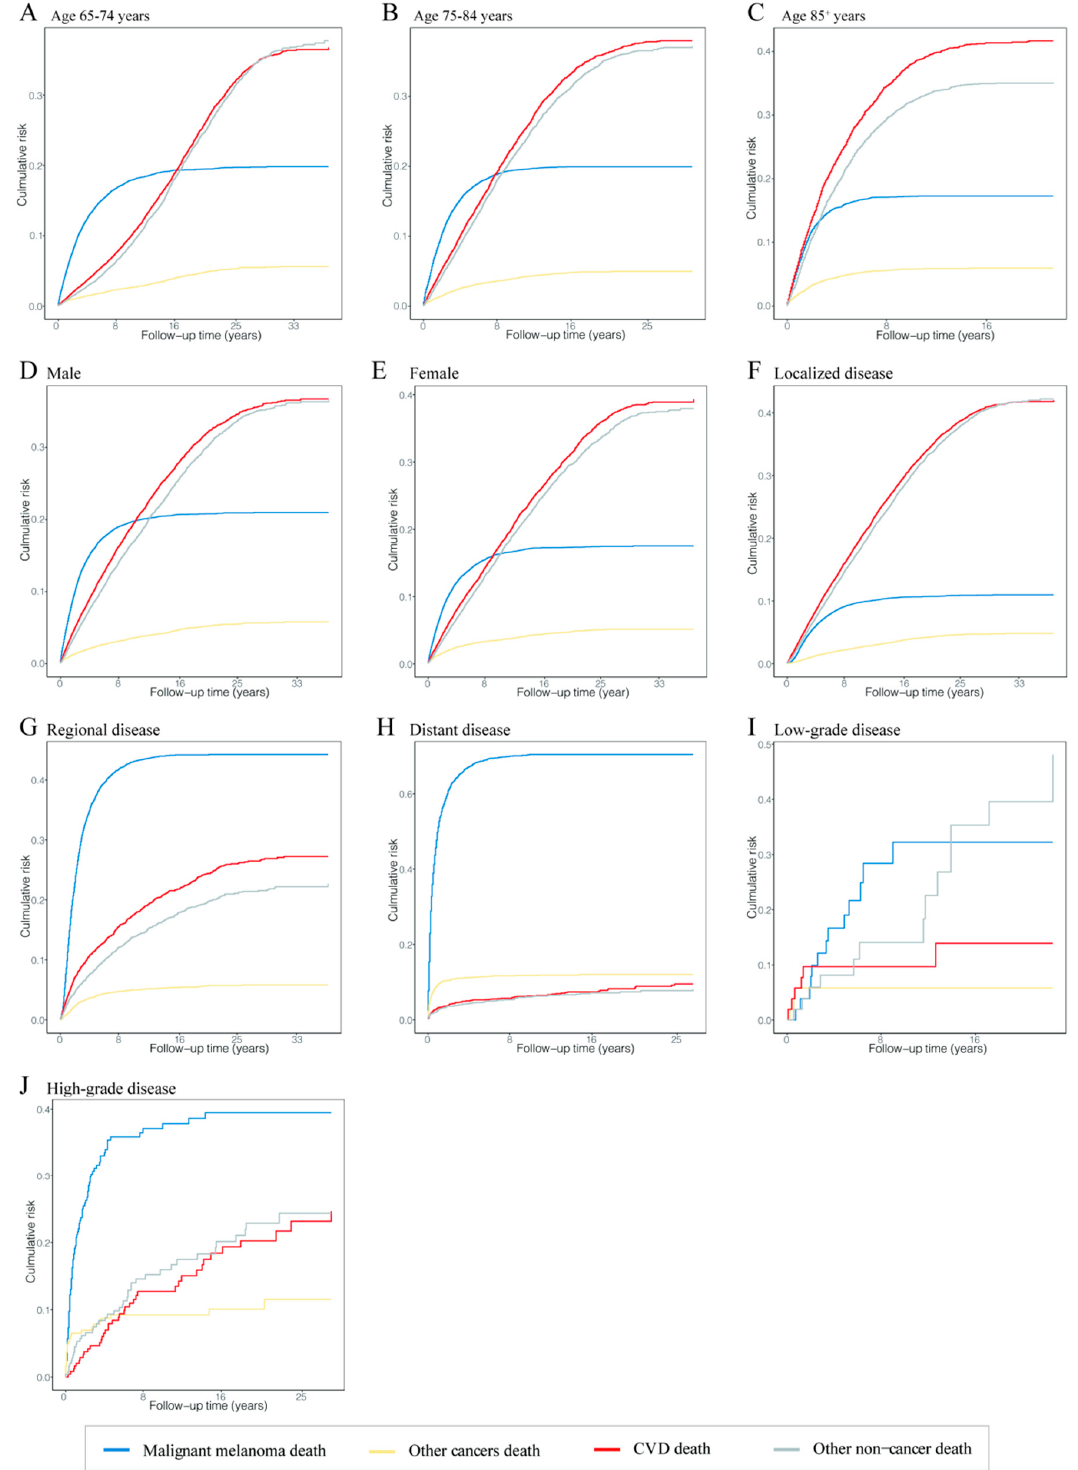
Figure 3. Cumulative mortality curves at time of follow-up in different malignant melanoma patient subgroups. The four curves show the cumulative mortality curves of malignant melanoma death (blue), other cancer death (yellow), cardiovascular disease death (red) and other noncancer death (gray), respectively. ( A ) Patients diagnosed at 65–74 years. ( B ) Patients diagnosed at 75–84 years. ( C ) Patients diagnosed at 85 + years. ( D ) Male patients. ( E ) Female patients. ( F ) Patients with localized disease. ( G ) Patients with regional disease. ( H ) Patients with distant disease. ( I ) Patients with low-grade disease. ( J ) Patients with high-grade disease. Abbreviation: CVD, cardiovascular disease.